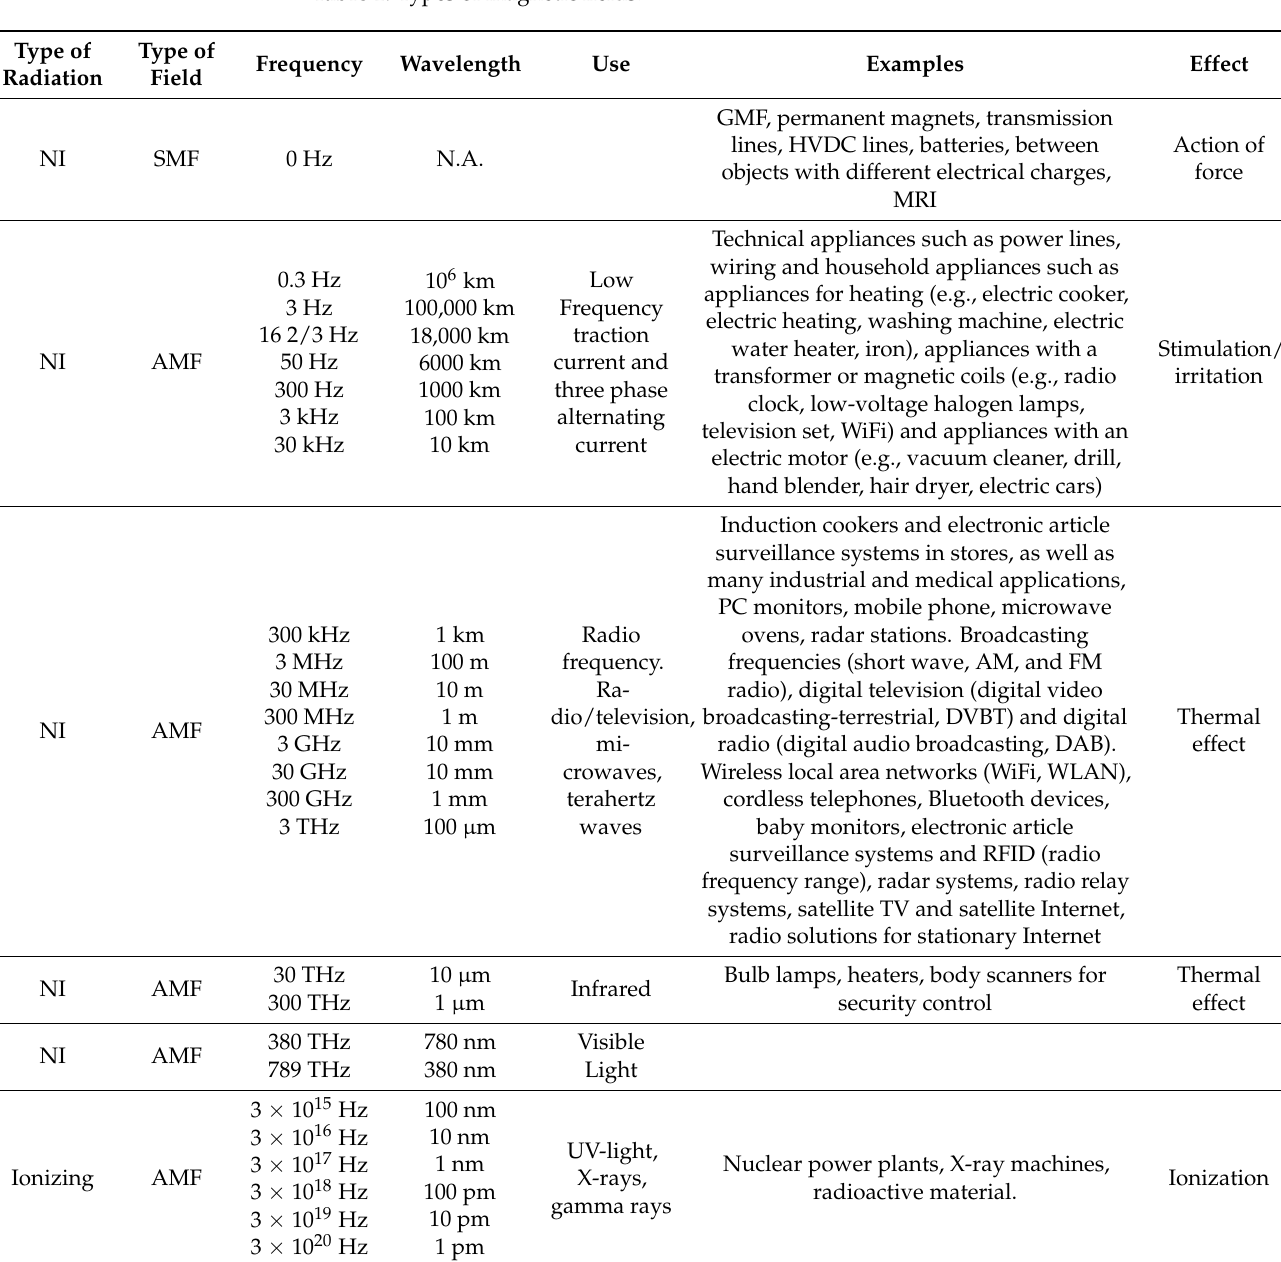
Table 1. Types of magnetic